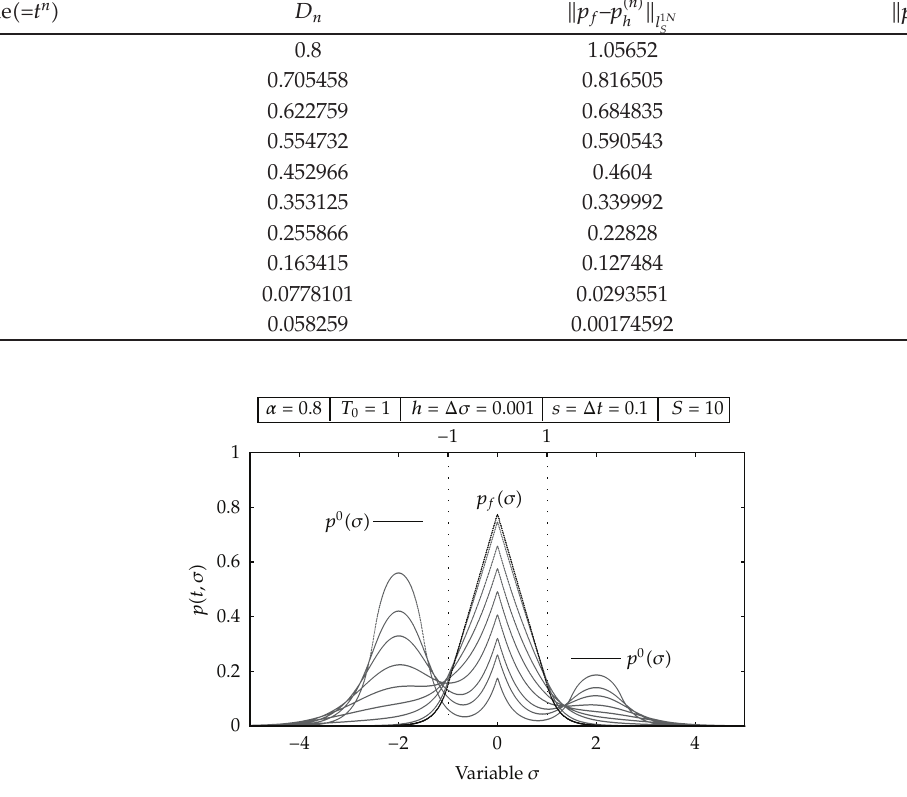
Figure 3: Graphics sequence: Subcase